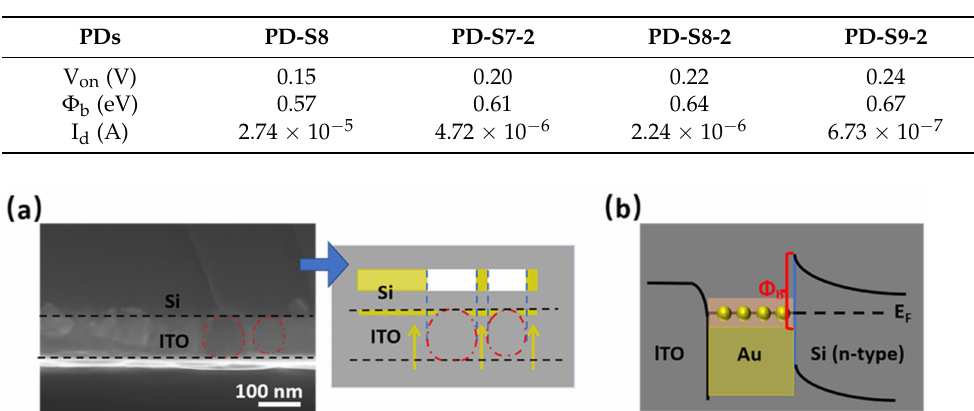
Table 1. V on , Φ B , and I d at − 1 V of PD-S8, PD-S7-2, PD-S8-2, and PD-S9-2.